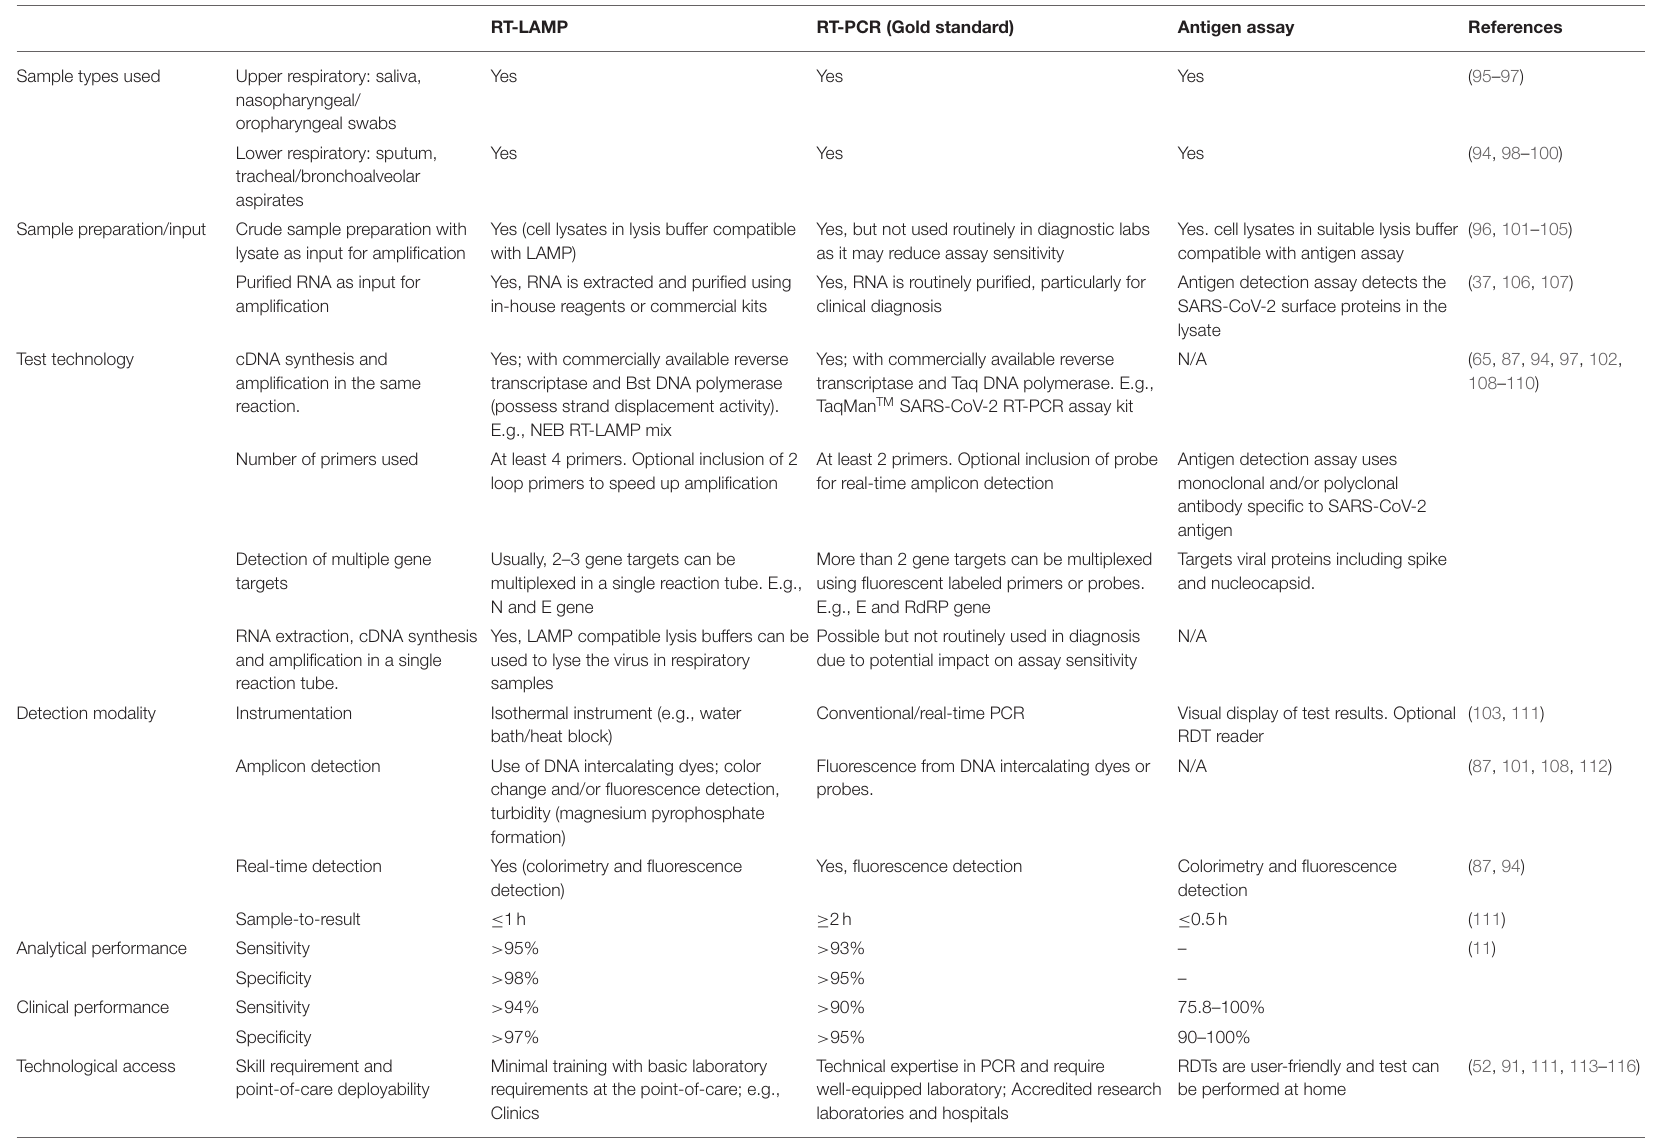
TABLE 1 | Attributes and performance of NAAT and antigen tests used for COVID-19 diagnosis. RT-LAMP RT-PCR (Gold standard) Antigen